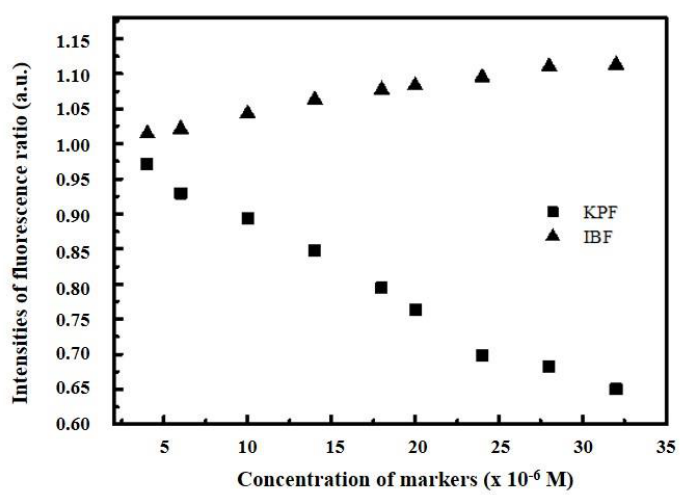
Figure 8. Intensities of fluorescence ratio for prothioconazole/ bovine serum albumin (PTC/BSA) complex in the presence of ketoprofen (KPF) and ibuprofen (IBF) markers.